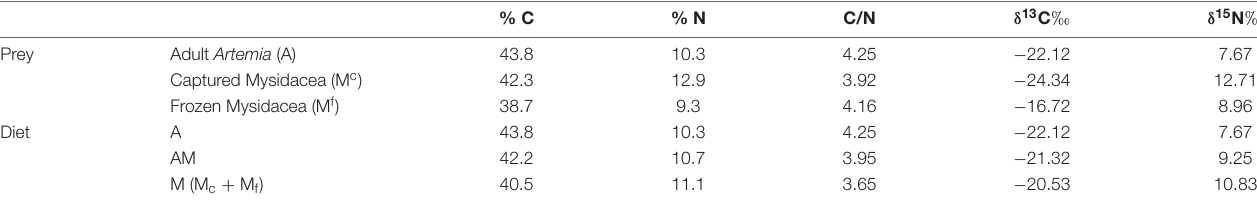
TABLE 1 | Average isotopic profiles ( δ 13